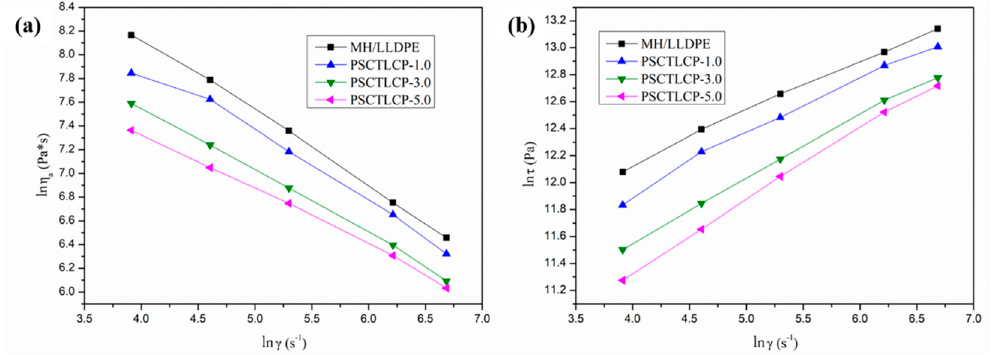
Figure 7. ( a ) Apparent viscosity, η a , versus shear rate, γ , temperature: 195 °C; ( b ) shear stress, τ , versus shear rate, γ , temperature: 195 °C.